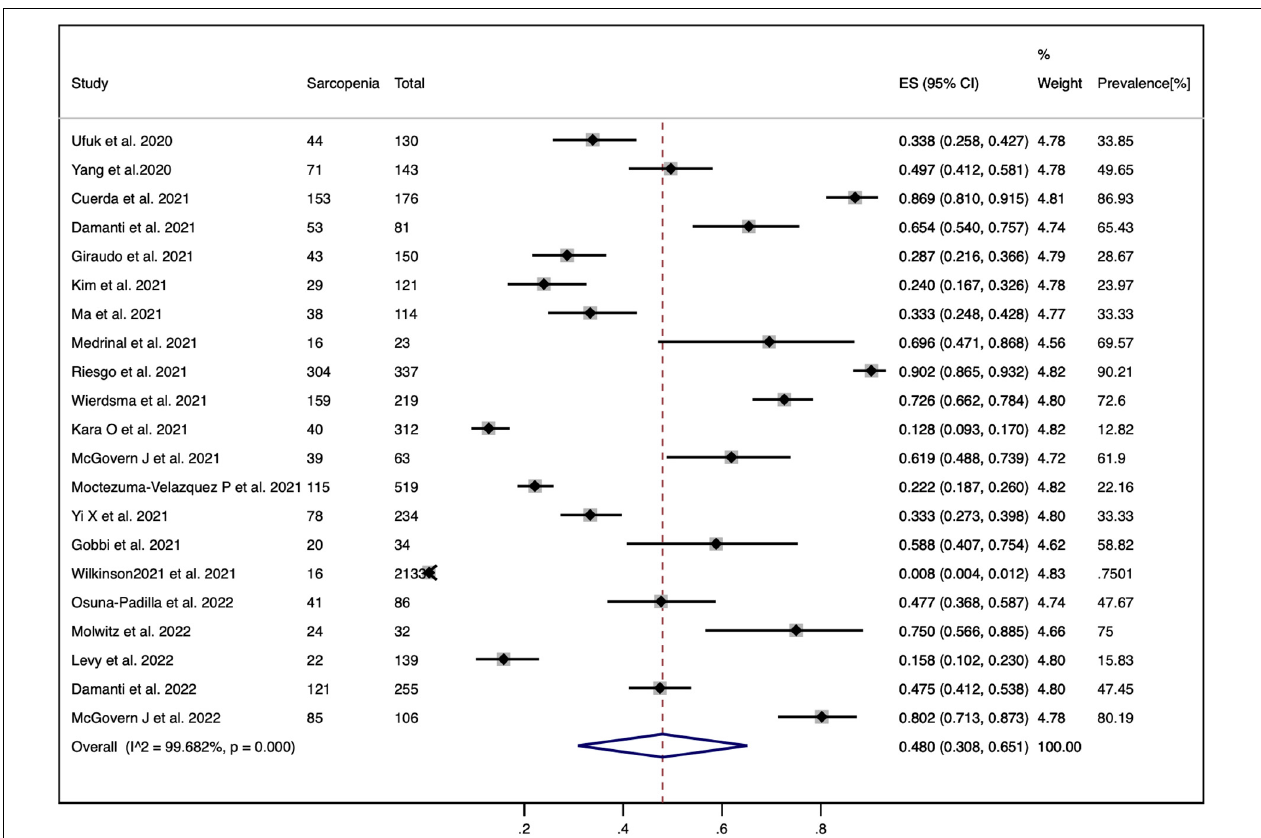
FIGURE 2 | The pooled prevalence of sarcopenia in COVID-19